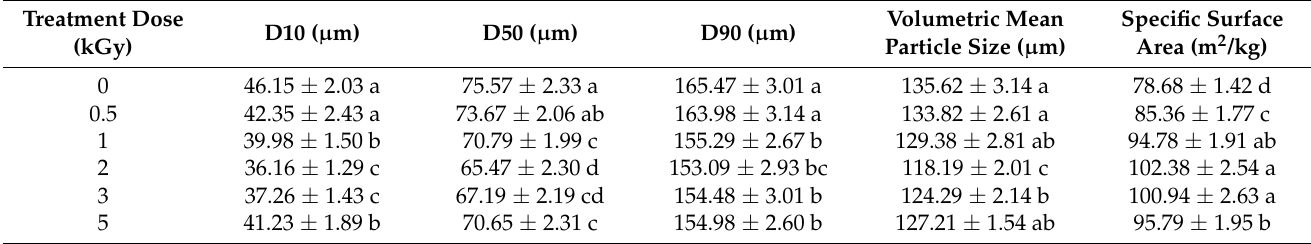
Table 2. Effects of γ -irradiation on particle size and specific surface area of okra pea